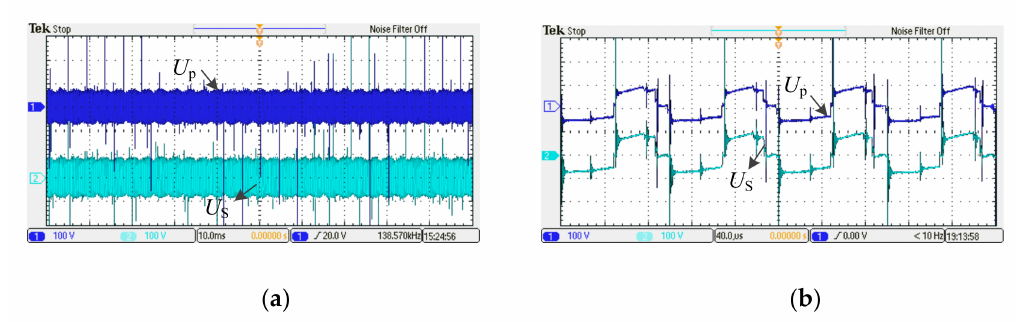
Figure 15. Experimental results with conventional solution. ( a ) Overall waveform ( b ) Detail waveform.